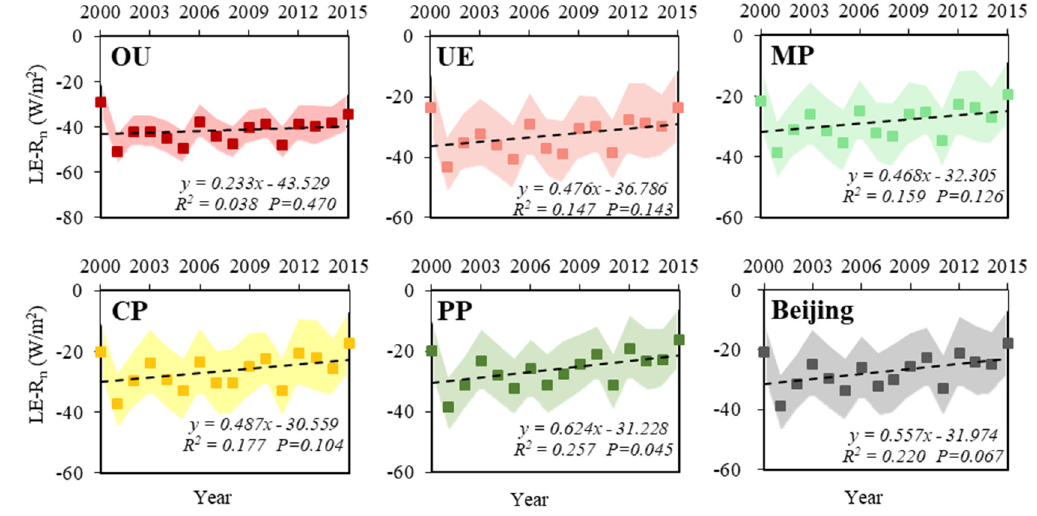
Figure 9. Variation trends of the di ff erence of latent heat flux and net radiation (LE − R n ) under various land use types in Beijing from 2000 to 2015.